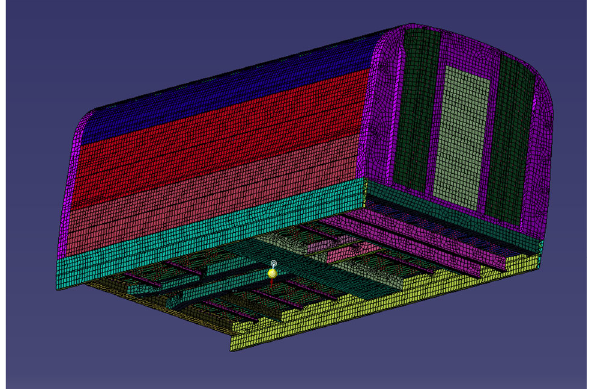
Fig. 11 Finite element model of vehicle body with a large mass point